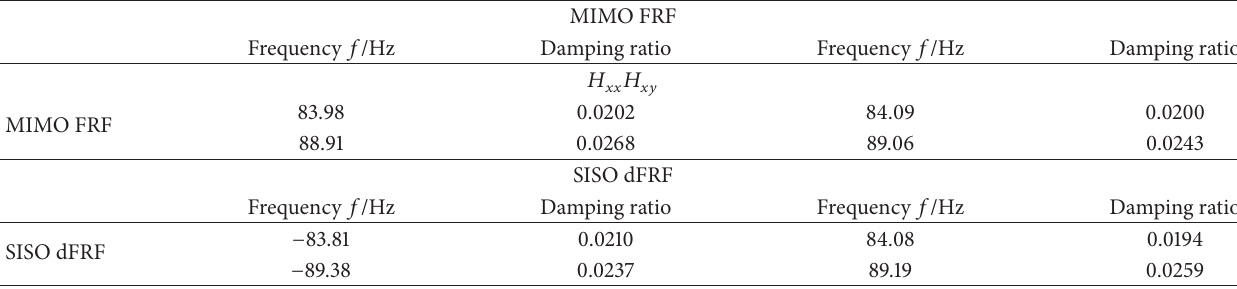
Table 4: Identified result based on MIMO FRF and SISO dFRF.